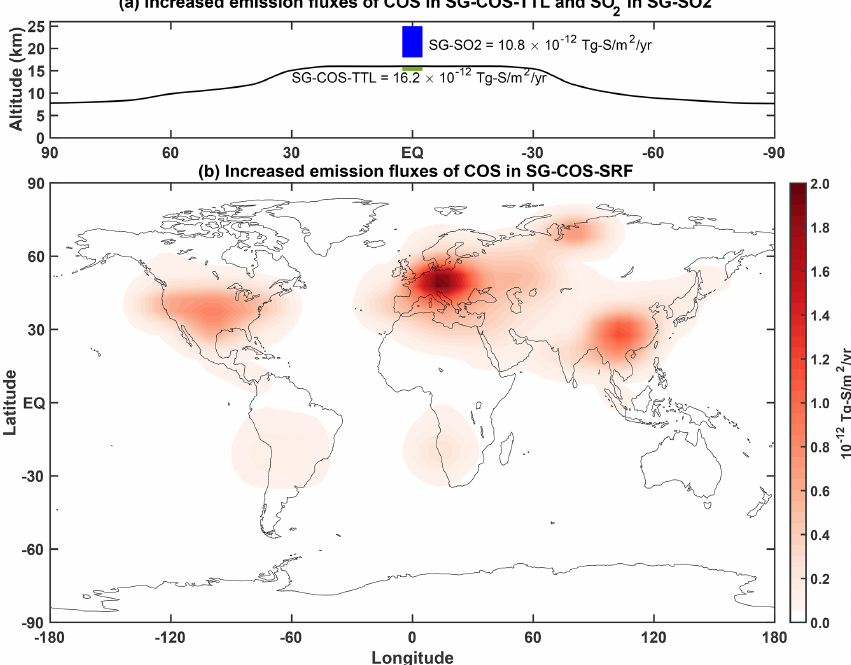
Figure 1. (a) Vertical and latitudinal distribution of COS emissions per year and unit of surface area (10 − 12 Tg − Sm − 2 yr − 1 ) in the SG- COS-TTL experiment (green box) and SO 2 emission fluxes in the same unit in SG-SO2 (blue box). The quantities are distributed in a single vertical level for SG-COS-TTL and in 12 vertical levels for SG-SO2. (b) Geographical distribution of COS emission fluxes per year and unit of surface area (10 − 12 Tg − Sm − 2 yr − 1 ) in the SG-COS-SRF experiment. The annual upward flux is averaged over the period